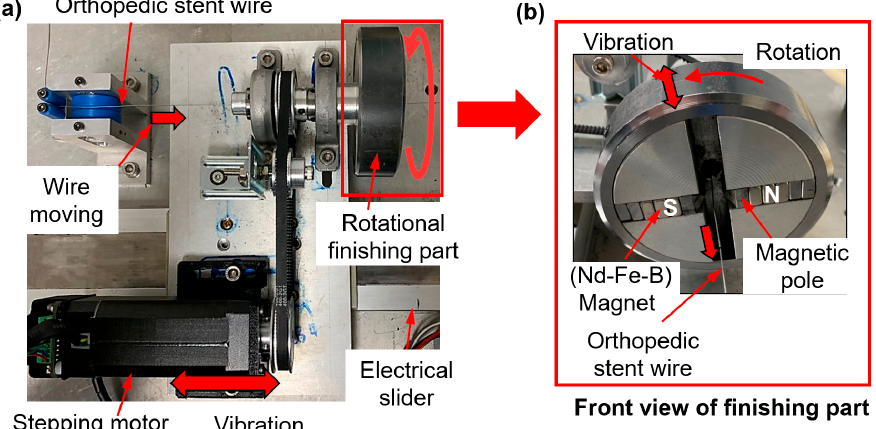
Figure 2. Experimental set-up of the MAF process for surface finishing of Ni-Ti (nitinol) wire. ( a ) Photograph of the magnetic field rotating system. ( b ) Front view of the finishing part.